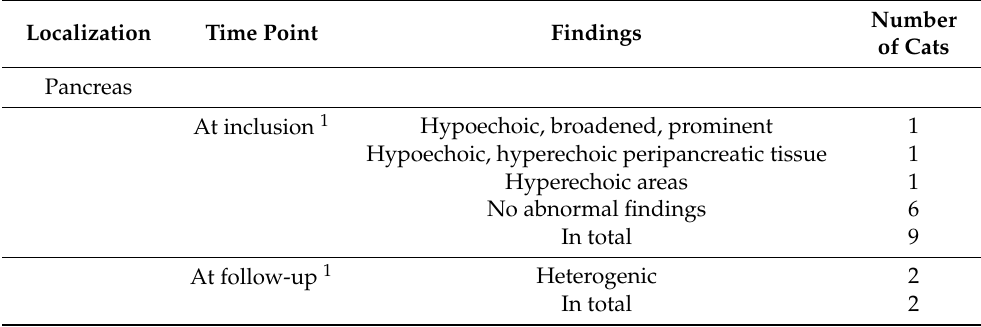
Table 5. Ultrasonographic reports of the pancreas and gastrointestinal tract (GI tract) in cats with presumed chronic pancreatitis treated with